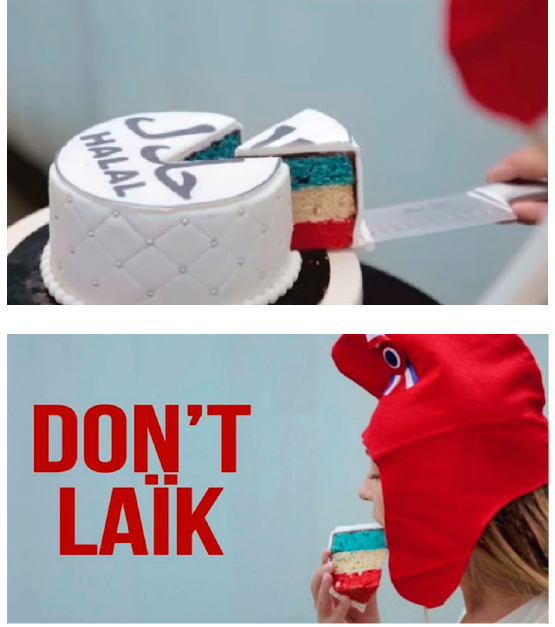
Figure 4. “Don’t Laïk”.